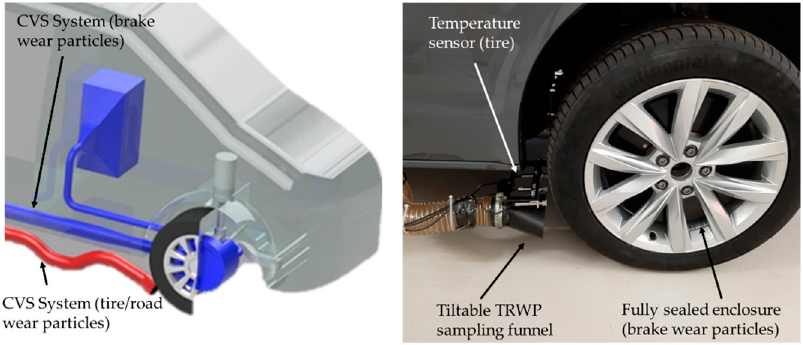
Figure 5. Sampling system for the capture of tire wear particles during on-road tests-positioning behind the right front wheel [28].